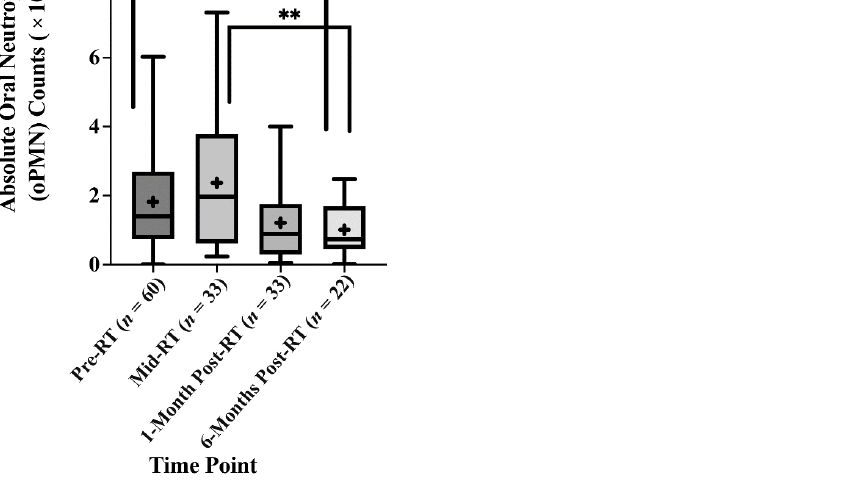
Figure 1. Radiotherapy causes a decrease in the oPMN counts. The absolute counts of the oral neutrophils were analysed across the four-time points. (+) The mean absolute oPMN count. (**) Statistically significant mean difference p < 0.005. tistically significant mean difference p <